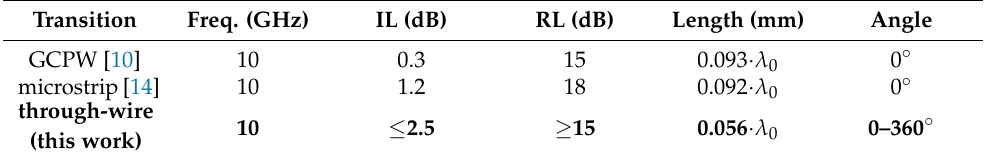
Table 4. Performance comparison of the through-wire transition with other transitions to ESICL. Transition Freq. (GHz) IL (dB) RL (dB) Length (mm)